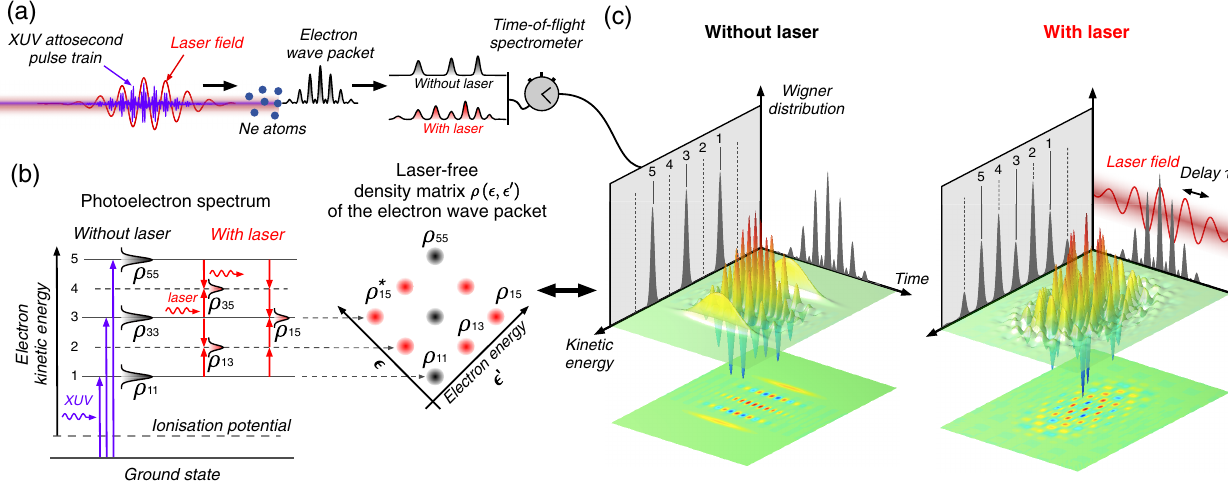
FIG. 1. Principle of a Mixed FROG measurement. (a) An XUV attosecond pulse train (purple curve) frees an electron wave packet (gray filled line) through photoionization. During this step, a laser pulse (red curve) modifies the wave packet, the kinetic energy spectrum of which is then measured with a time-of-flight spectrometer. (b) In the absence of a laser pulse, this spectrum gives the populations (the diagonal elements in black) of the laser-free density matrix ρ . Adding the laser pulse gives access to the off-diagonal elements of ρ (in red) through the emission or absorption of laser photons. (c) The state of the photoelectron wave packet can equivalently be described by a Wigner distribution W in the energy or time phase space. Measuring the energy spectrum for various XUV and laser delays provides a set of projections of W , which makes it possible to access the Wigner distribution by